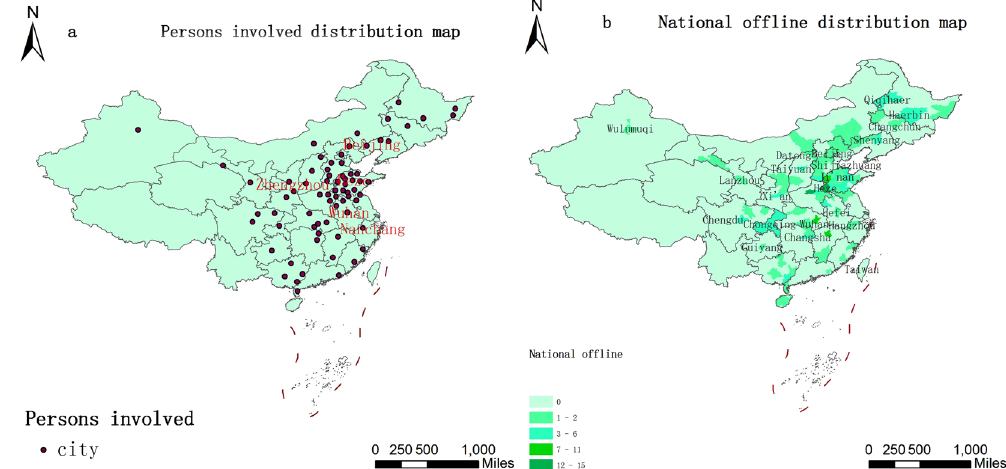
Figure 6. Persons involved distribution map ( a ) and National offline distribution map ( b ) (Maps created in ArcGIS 10.2 (Environmental Systems Resource Institute, ArcMap Release 10.2, Environmental Systems Resource Institute, ArcMap Release 10.2, ESRI, Redlands,